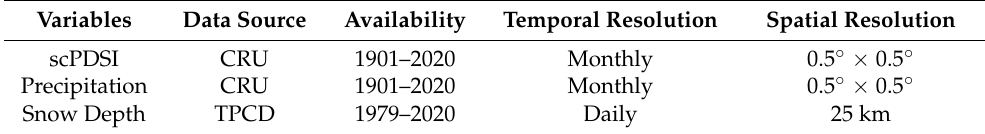
Table 1. Summary of the datasets used in the